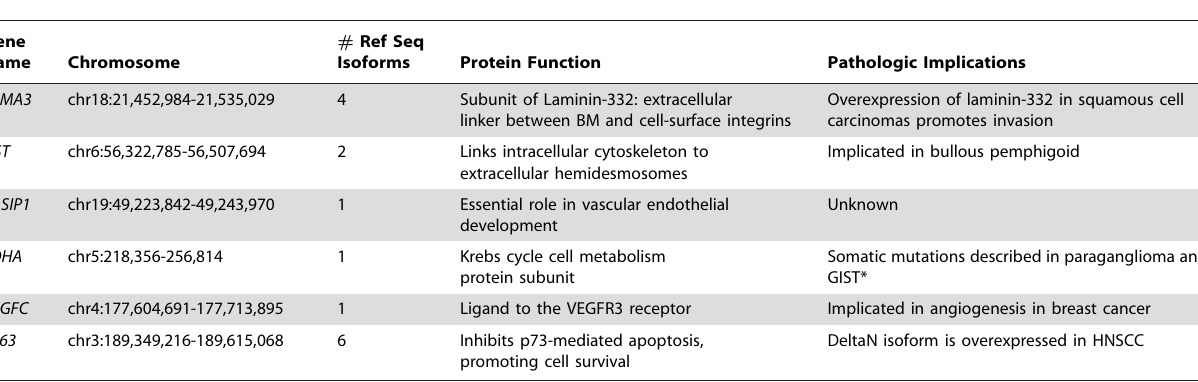
Table 5. Descriptive summary of genes selected for quantitative RT-PCR validation of alternative splicing